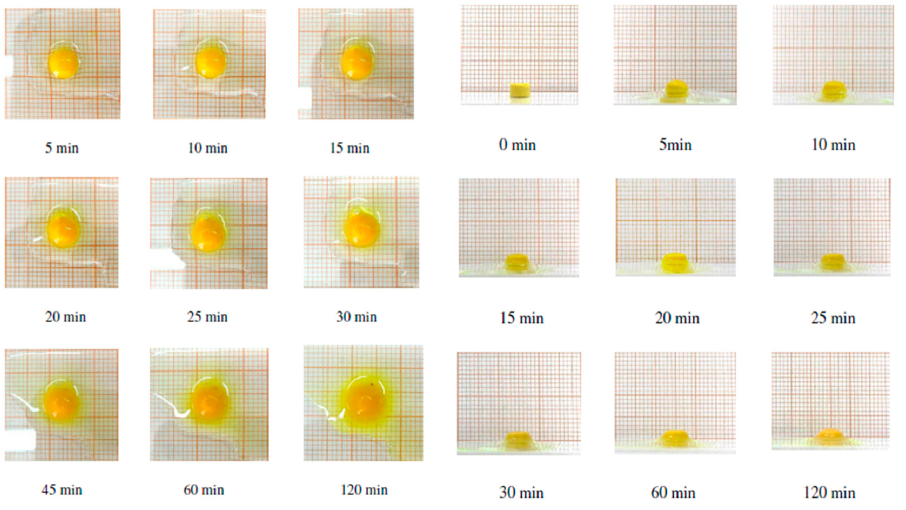
Figure 7. Swelling index measured as weight increase versus time.